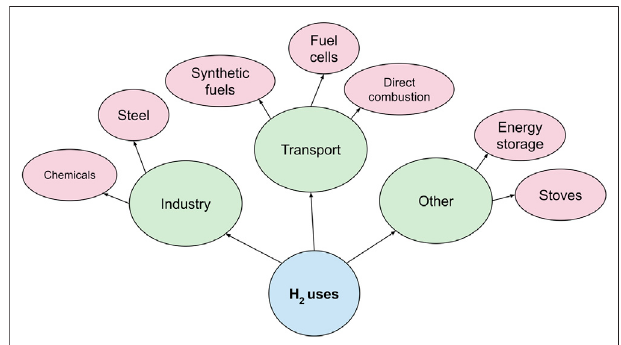
FIGURE 1 | Summary of the main possible usages of H 2 by